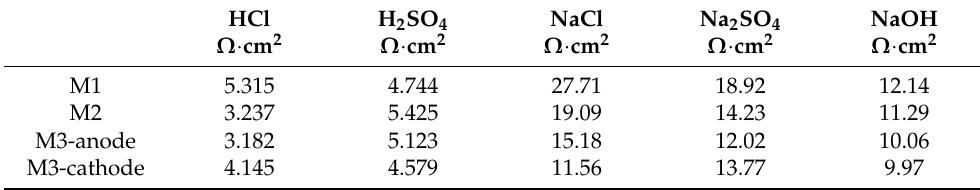
Table 2. Solution resistance fitted by EIS.